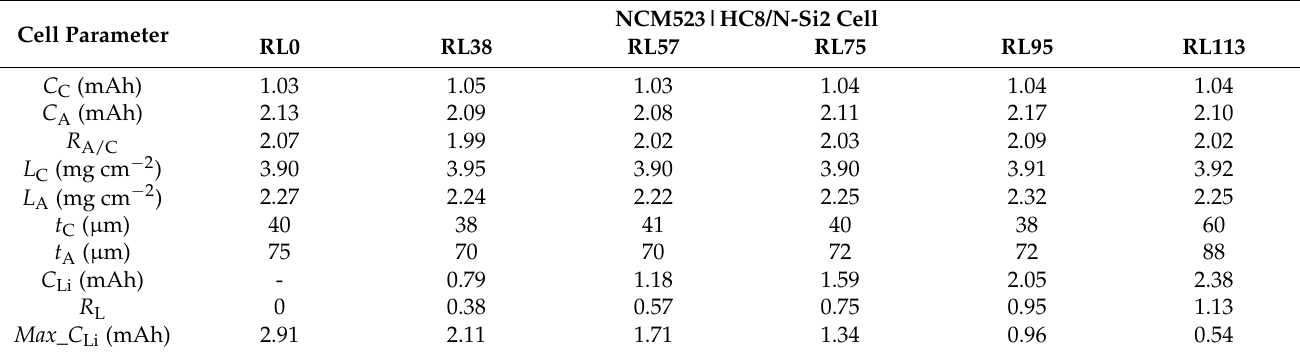
Table 2. Design parameters for NCM|HC8/N-Si2